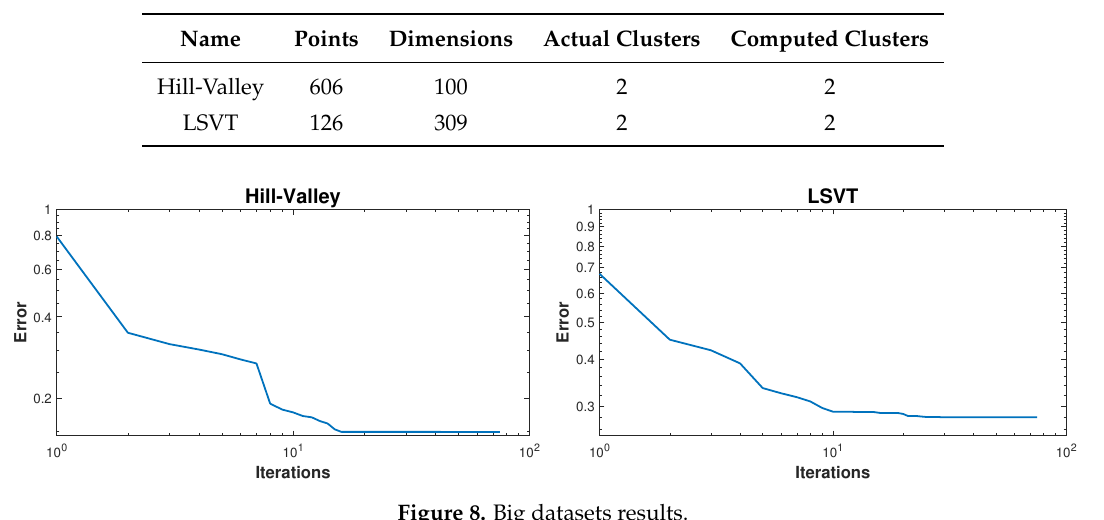
Table 6. Datasets with big numbers of attributes.